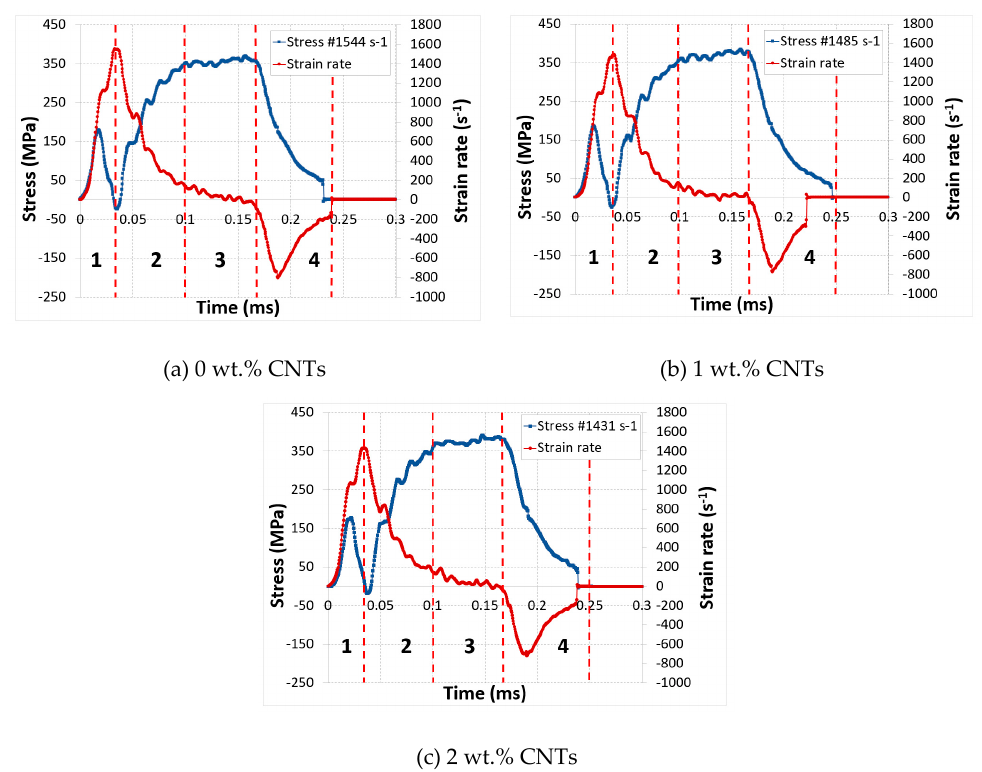
Figure 12. Evolution of the stress and strain rate vs time curves for different mass fraction, P = 4 bar.